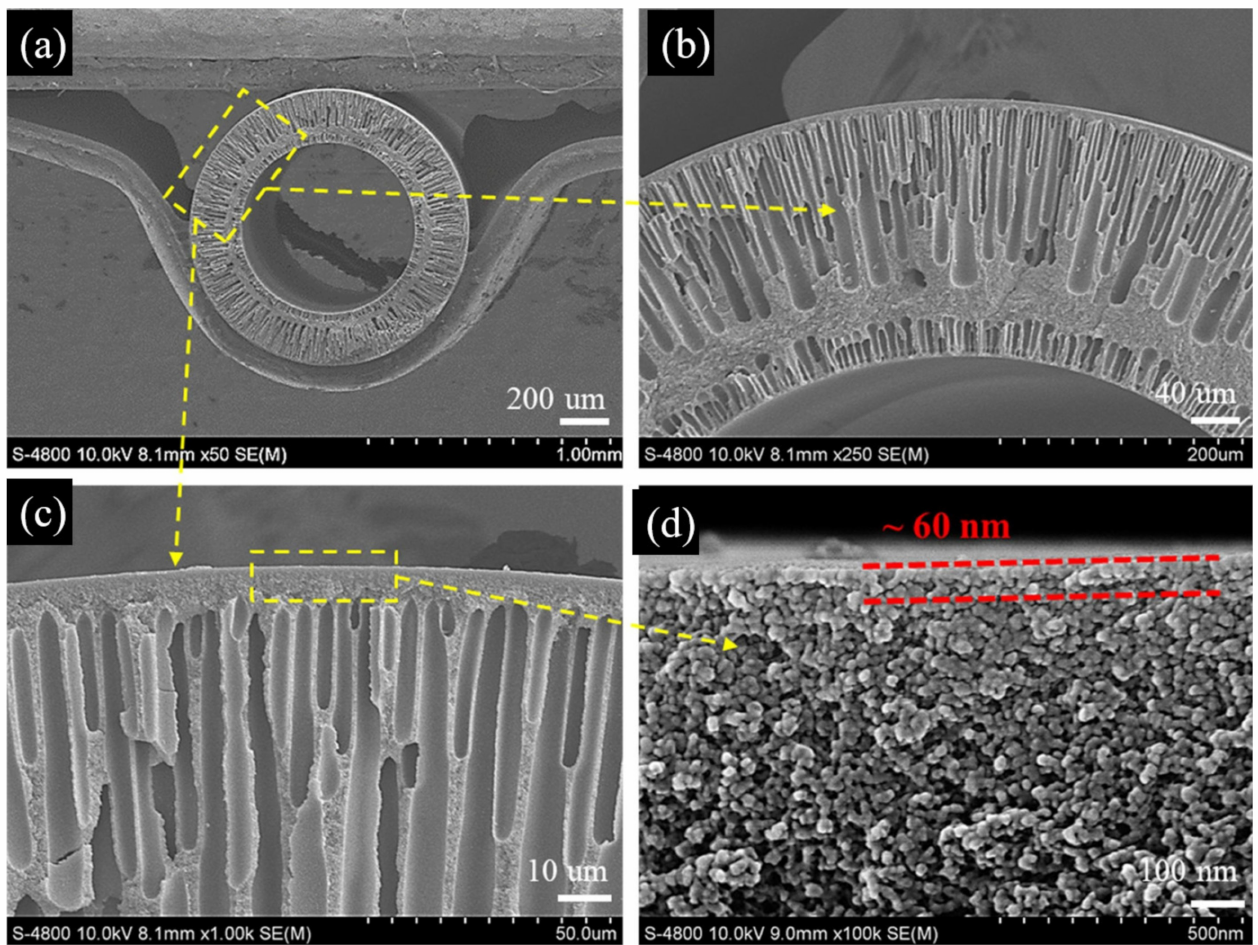
Figure 8. The SEM images of the cross section of PI TFC HF OSN membranes with a 60 nm thickness dense PA selective skin layer including ( a ) 50 × magnification; ( b ) 250 × magnification; ( c ) 1000 × mag- nification; ( d ) 100,000 × magnification. Reprinted and adapted with permission from Ref. [15]. Copyright 2022,